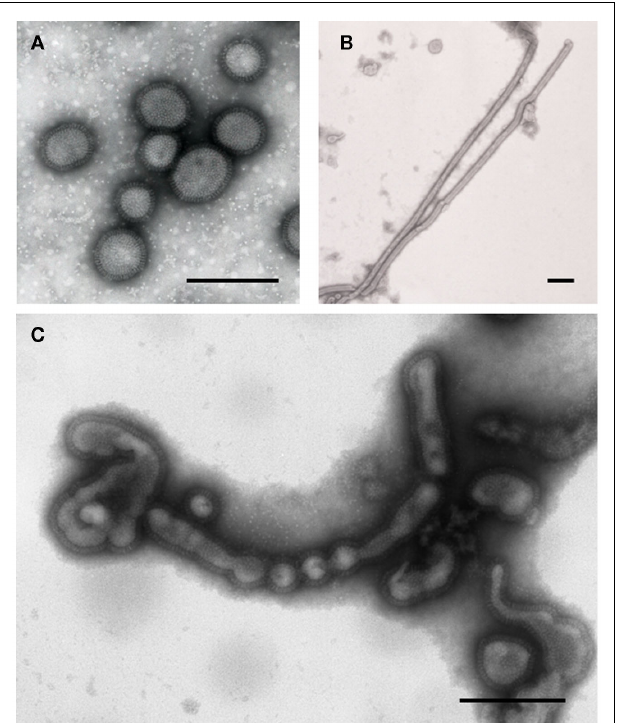
FIGURE 1 | Electron micrograph of influenza virions. The virions were purified by ultracentrifugation, and visualized by negative-staining EM. Bars, 200nm. (A) Spherical virions [A/WSN/33 (H1N1)], (B) filamentous virions [A/Udorn/307/72 (H3N2)], and (C) irregular-shaped virions [A/Puerto Rico/8/34